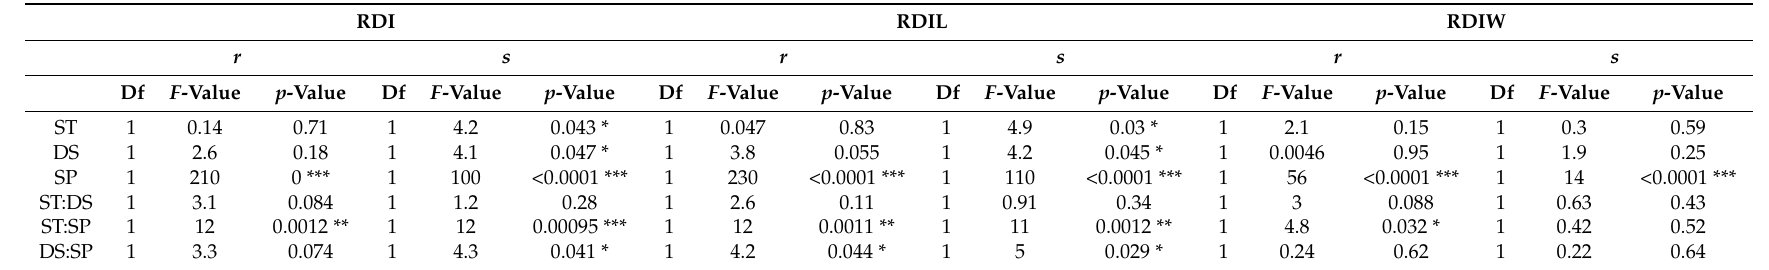
Table 3. Analysis of variance for both beta distribution parameters ( r and s ) and the three profile types (Equation (5)). Fixed effect of stand type (ST), developmental stage (DS) species (SP), the interaction between stand type and developmental stage (ST:DS), between stand type and species (ST:SP) and between developmental stage and species (DS:SP) are